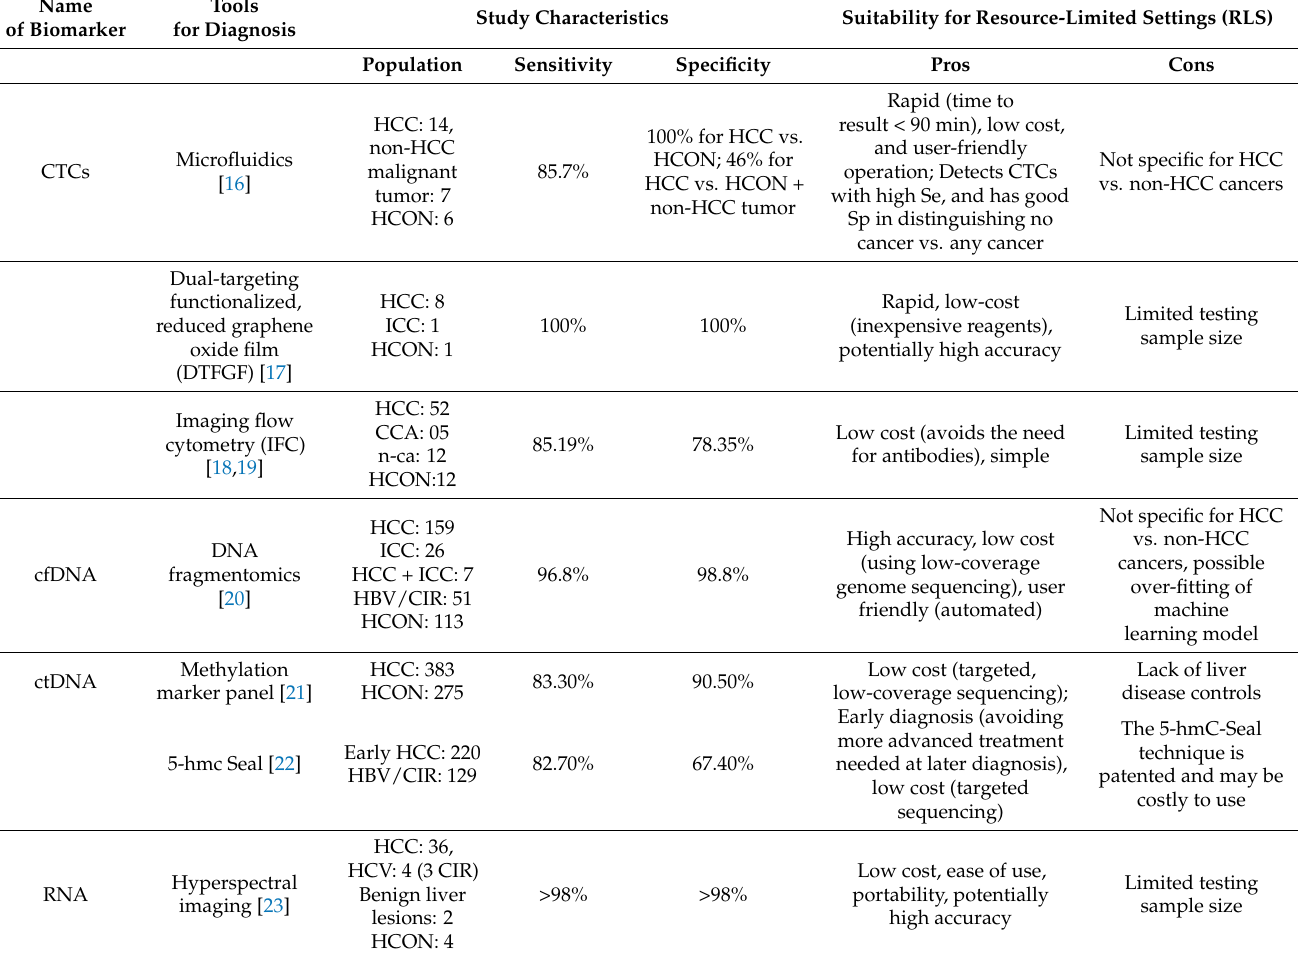
Table 1. Clinical studies of novel, low-cost methods for detecting HCC biomarkers in the blood *. Name of